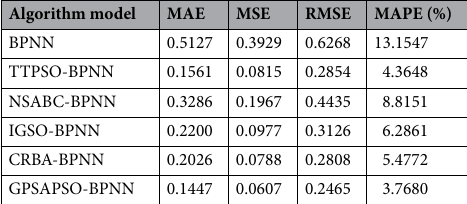
Table 9. Error comparison of different algorithms.